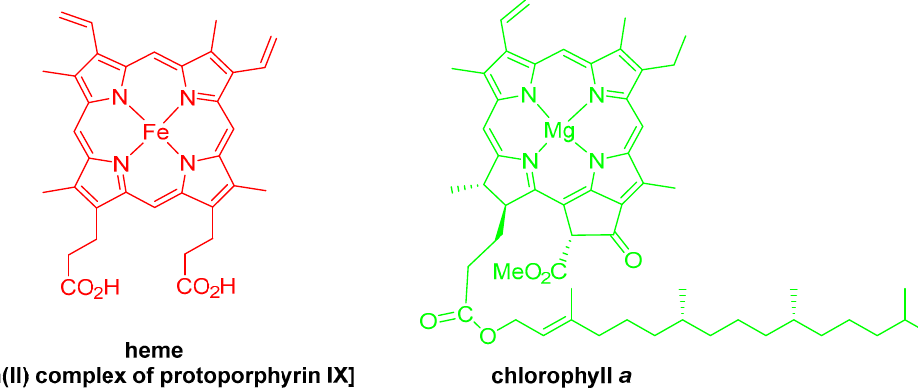
Figure 1. The structures of heme and chlorophyll a .